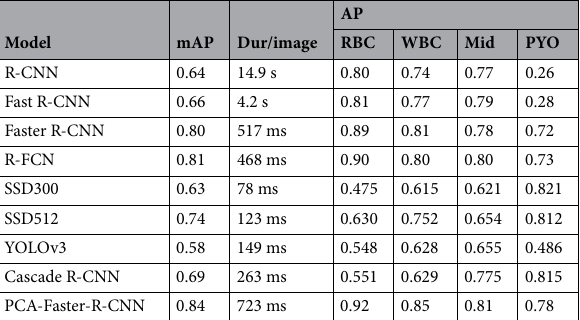
Table 2. Comparison of 5 cell-detection algorithms. Dataset C was used to validate the average precision.